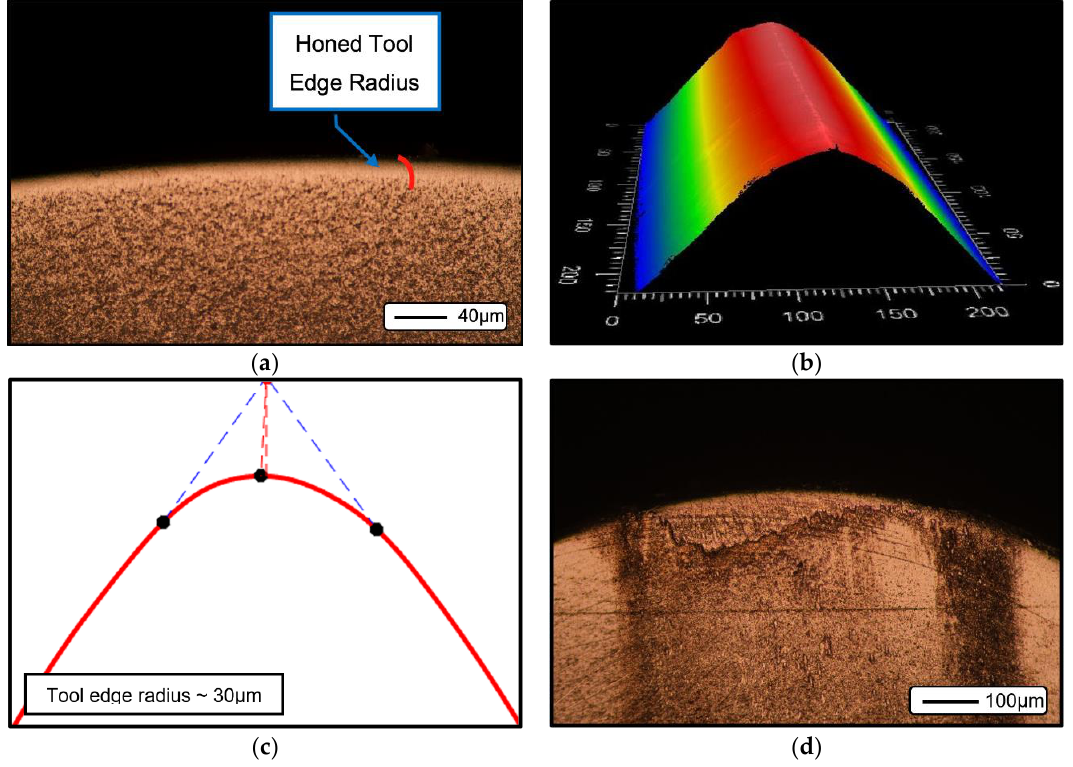
Figure 4. ( a ) Rake face view of the modified edge of a Kennametal TPGN K-68 tool of r c = 3.2 mm, r e = 30 µm; ( b ); tool cloudmap produced via scanning white light interferometer; ( c ) subsequent analysis of tool cloudmap via MATLAB; ( d ) used tool exhibiting tool/workpiece contact discoloration and limited adhesion, but no tool (edge or nose) wear.